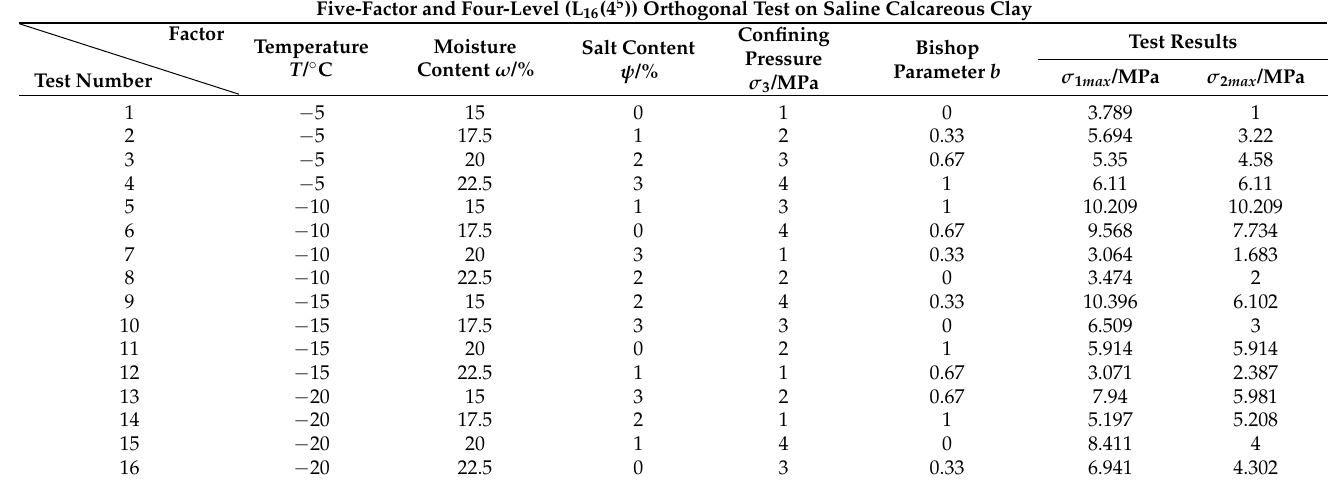
Table 3. Design and results of true triaxial orthogonal test conducted on saline calcareous clay [23].